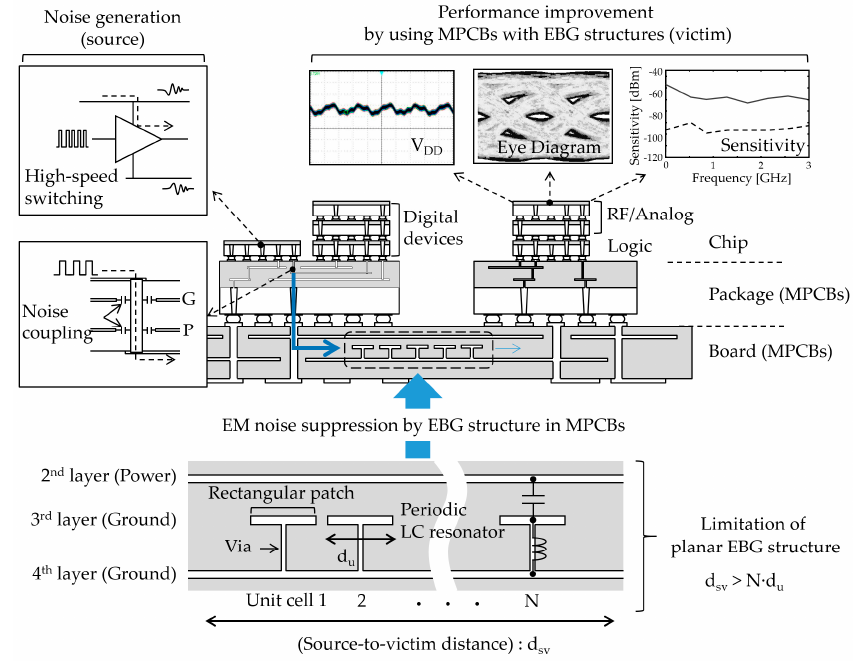
Figure 1. Gigahertz (GHz)-noise suppression in multilayer printed circuit boards using electromagnetic bandgap structures and the limitations of previous planar electromagnetic bandgap (EBG) structures.